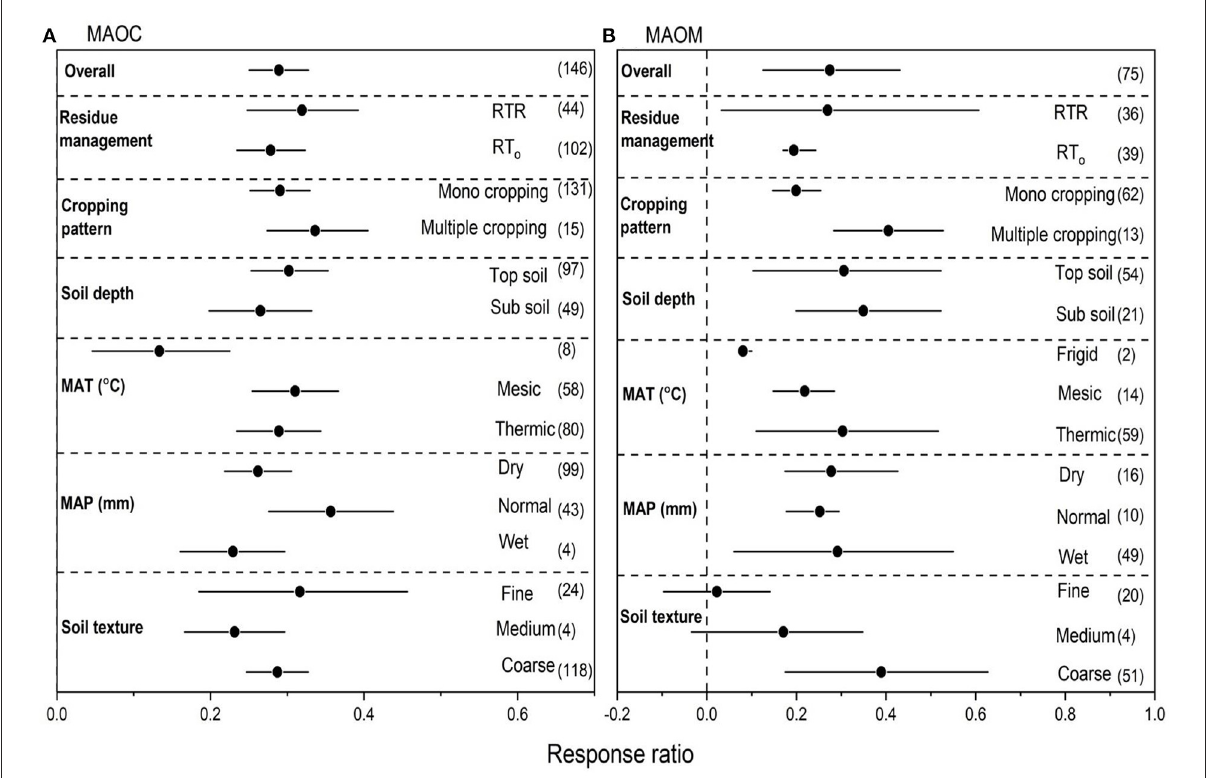
FIGURE5 (A,B) The effect size of mineral associated organic carbon (MAOC) and mineral associated organic matter (MAOM) with RT compared to CT. If 95% confidence intervals (CIs) do not overlap with zero, there is a substantial difference in the effect size between treatments. Error bars display CIs. The sample size for each variable is displayed next to each bar. The acronyms stand for mean annual temperature (MAT), mean annual precipitation (MAP), retention of residue (RTR), and no residue retention